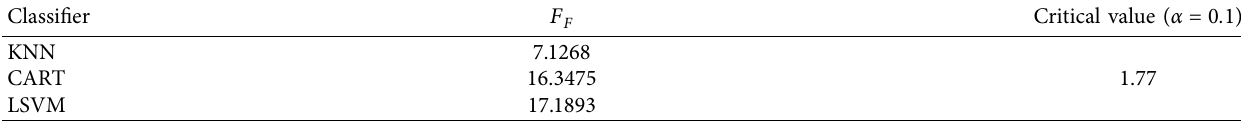
Figure 3: Comparison of robustness of different FRS models on LSVM. Table 5: Friedman statistical coefficients F F and corresponding critical